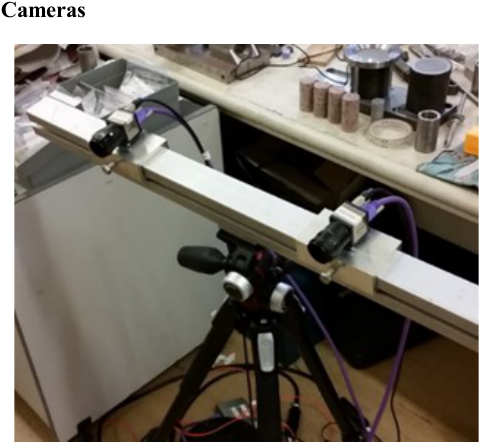
Figure 1. IDS cameras on the base